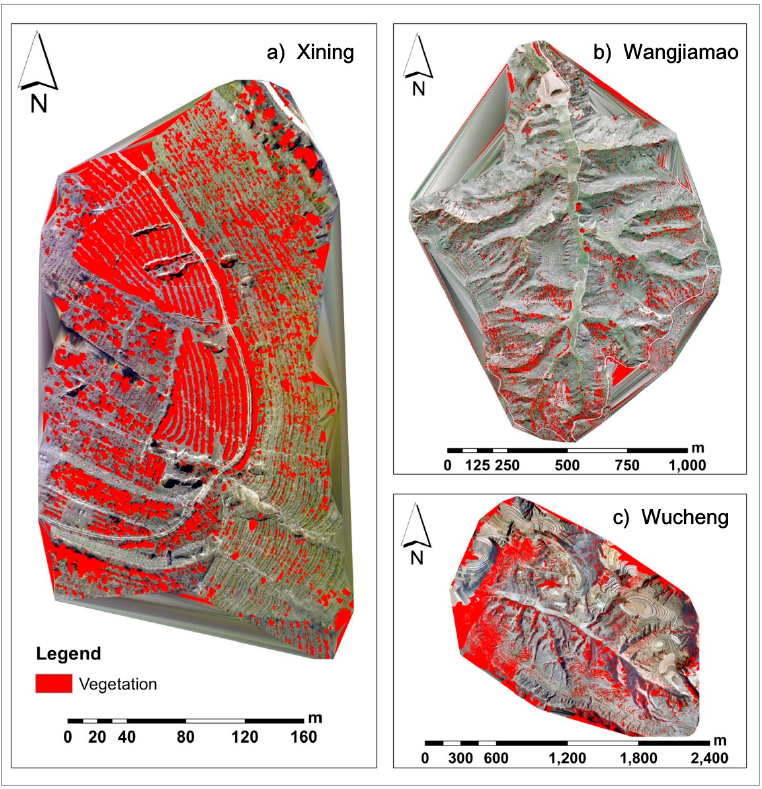
Figure 4. Vegetation detection result. ( a ) Xining; ( b ) Wangjiamao; and ( c ) Wucheng